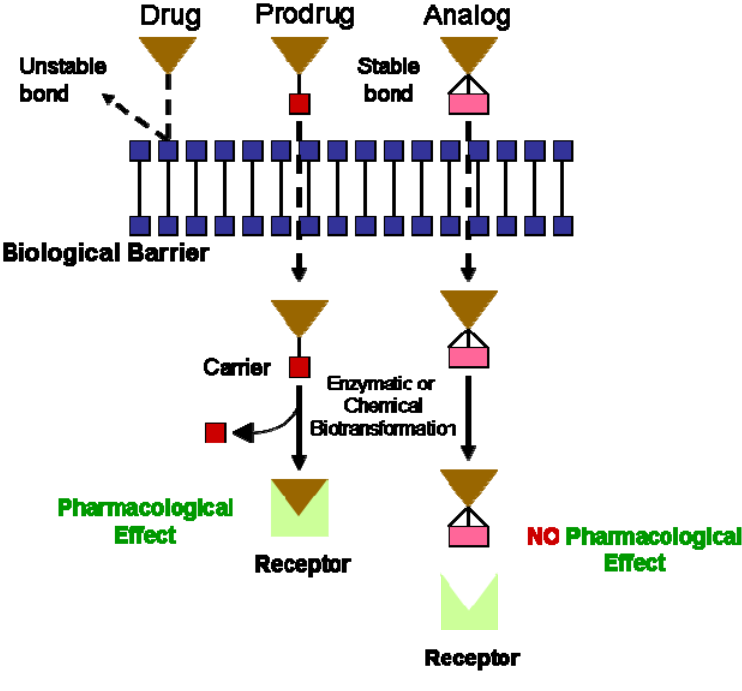
Figure 1. The distinction between prodrugs and analogs (adapted from